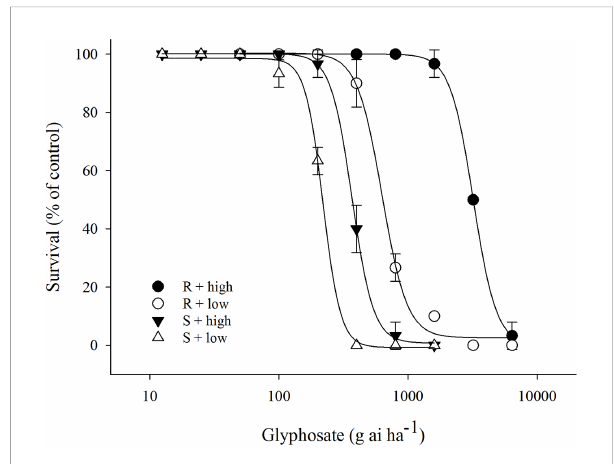
FIGURE 1 Plant survival response to glyphosate treatment in glyphosate- resistant (R) and -susceptible (S) Eleusine indica biotypes grown under high temperature (30°C/25°C day/night) and low temperature (20°C/15°C day/night) regimes. The experiment was repeated with similar results. Each data point is the mean ± standard error of three replicates from one